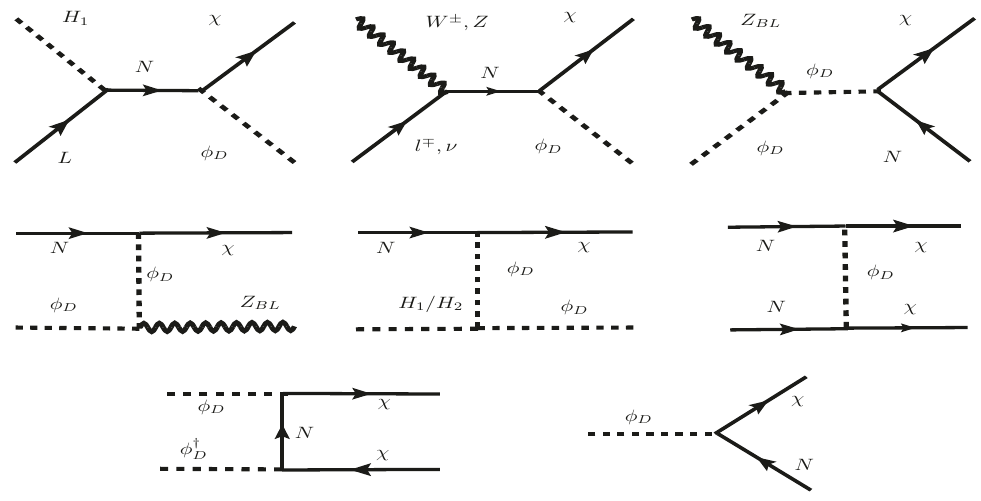
Figure 1 . Different contributions for the production of the DM χ . The s and t channels diagrams give negligible contributions compared to the decay